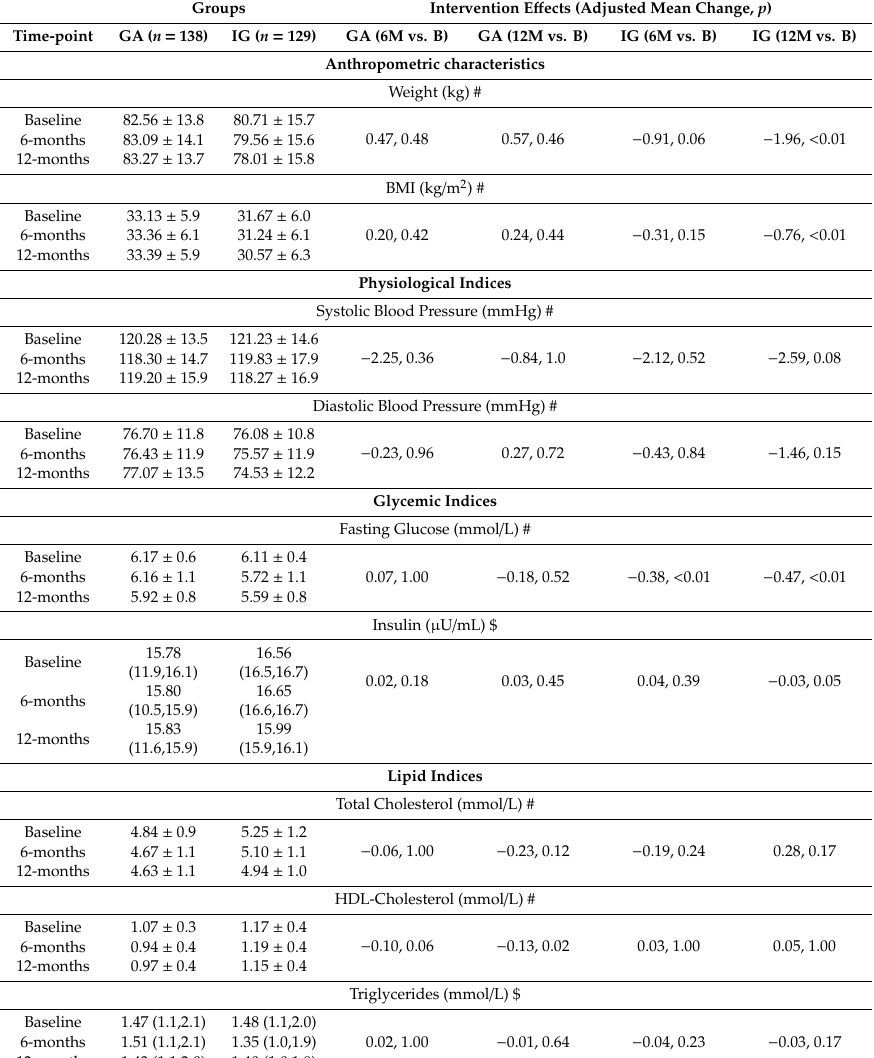
Table 3. Anthropometric, glycemic, and lipid indices of participants over time. Groups Intervention E ff ects (Adjusted Mean Change, p